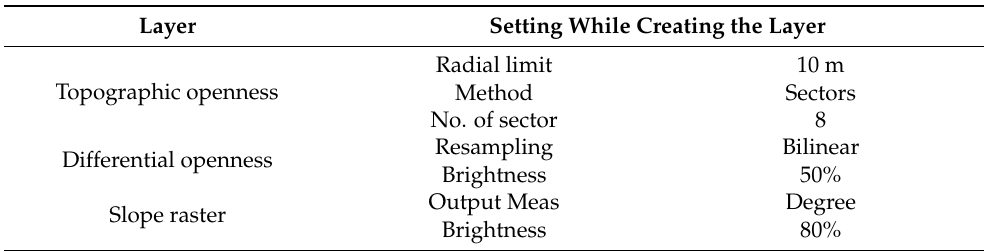
Table 4. The layers (slope maps, differential openness, and topographic openness) used to create the Red Relief Image Maps (RRIMs). Layer Setting While Creating the Layer Radial Topographic openness